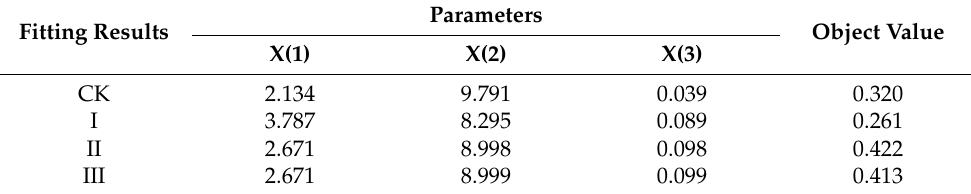
Table 2. Optimum parameters obtained by the CROBAS-CL